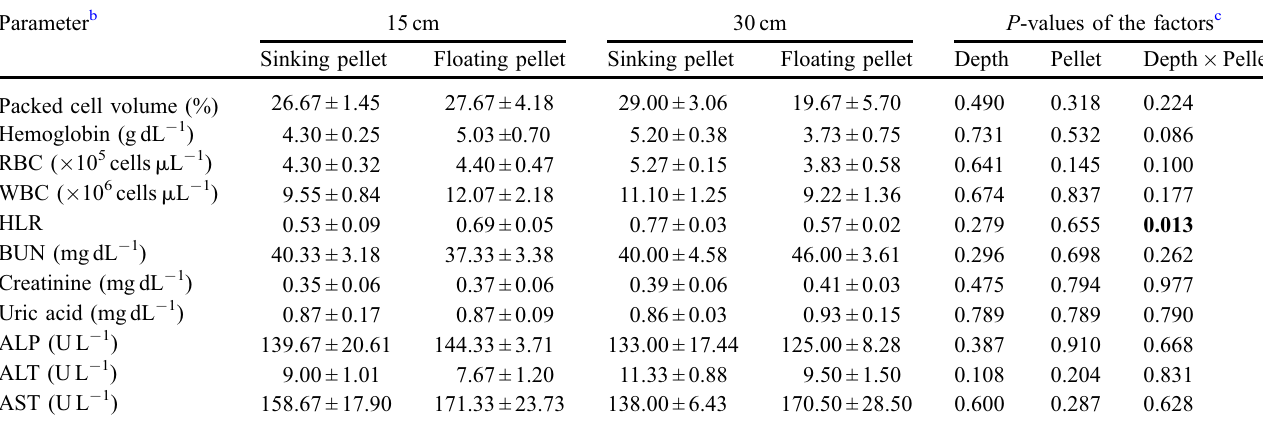
Table 5. Hematological parameters of post-hatching green turtles reared under different water depths (15 and 30cm) and fed with commercial feed pellets (sinking or fl oating type). a The data (mean±SEM) are for turtles sampled at the end of the